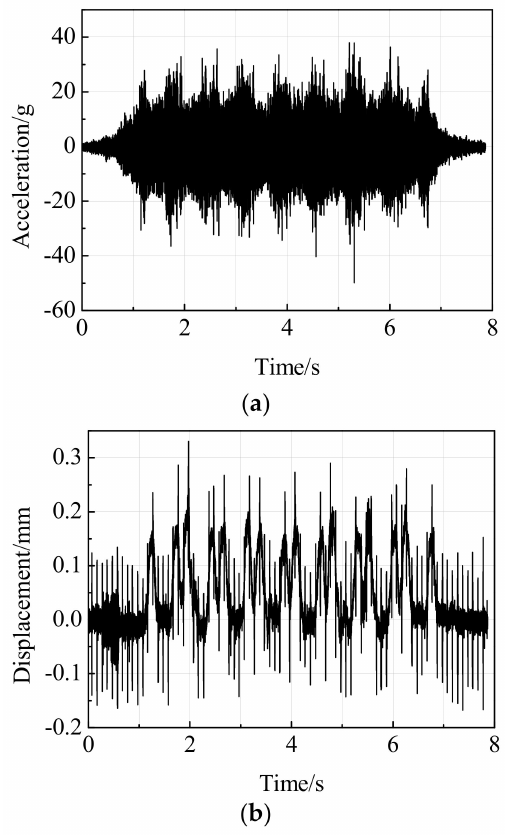
Figure 1. The typical dynamic response waveform: ( a ) displacement; ( b )